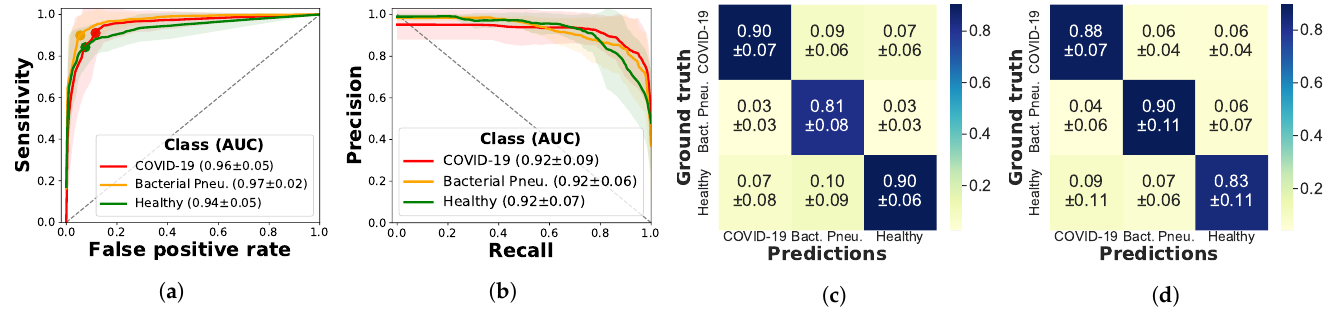
Figure 3. Performance of the VGG model. Per-class ROC-AUC, sensitivity, and precision are shown on the diagonals of the normalized confusion matrices, highlighting the model’s ability to distinguish COVID-19 from pneumonia and healthy lung images. It further demonstrates similar scores and balanced confusions between each pair of classes. ( a ) ROC-curves, ( b ) Precision-recall-curves, ( c ) Precision-confusion matrix, ( d ) Sensitivity-confusion